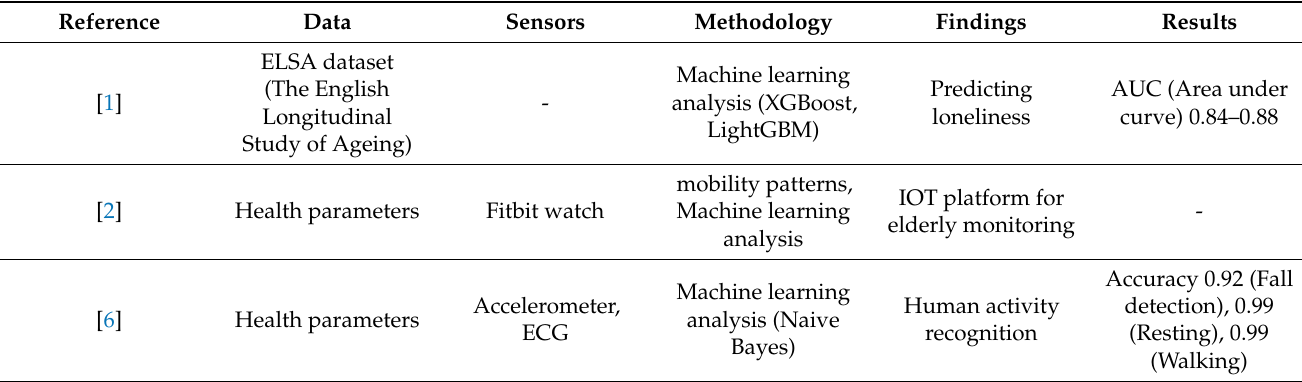
Table 1. Previous studies comparison with current